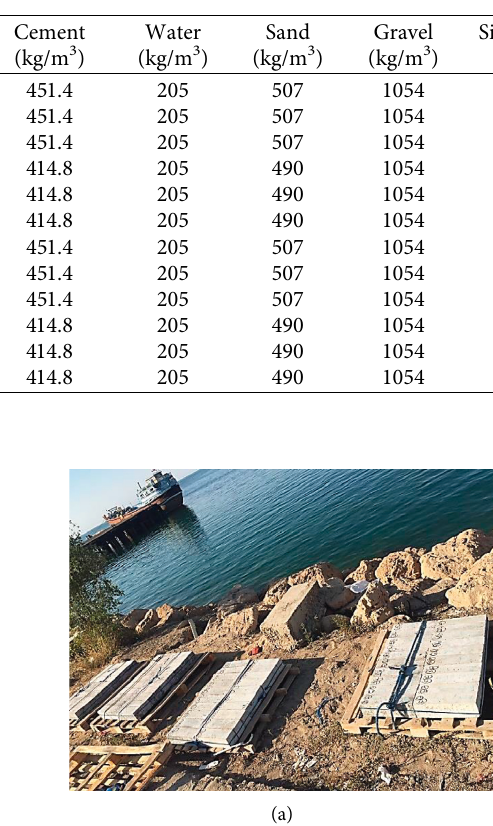
Table 5: Green concrete mix proportions.